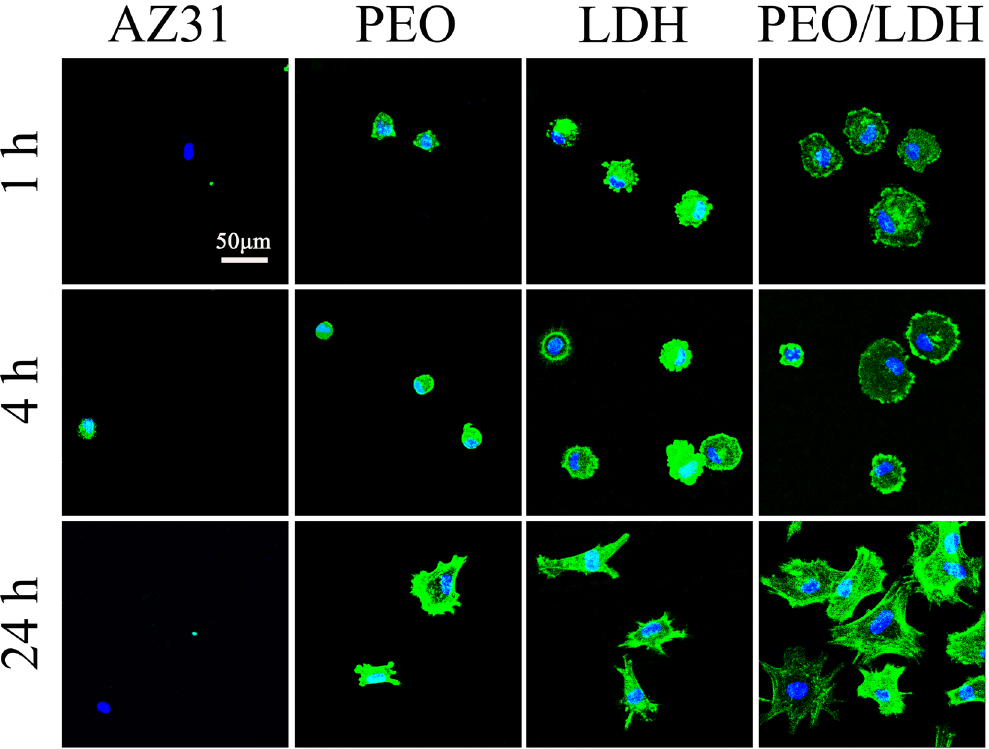
Figure 8. CLSM images of cells cultured on various surfaces for 1, 4 and 24 h with actin stained with FITC (green) and nucleus stained with DAPI (blue).